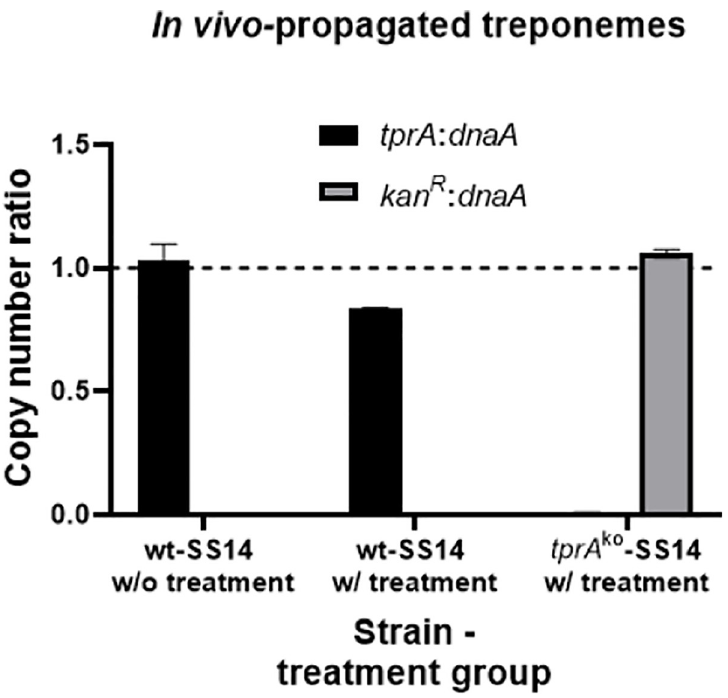
Fig 7. Droplet digital PCR (ddPCR) on DNA template from the tprA ko - and wt- SS14 strain propagated in rabbits to which kanamycin was (w/) or was not (w/o) given. The only IACUC-approved administration route for kanamycin, however, resulted in treatment failure in rabbits infected with the wt-SS14 strain. tprA : dnaA ratio for the tprA ko -SS14 strain was 0.007; kan R : dnaA ratio for the wt-SS14 strains was zero.